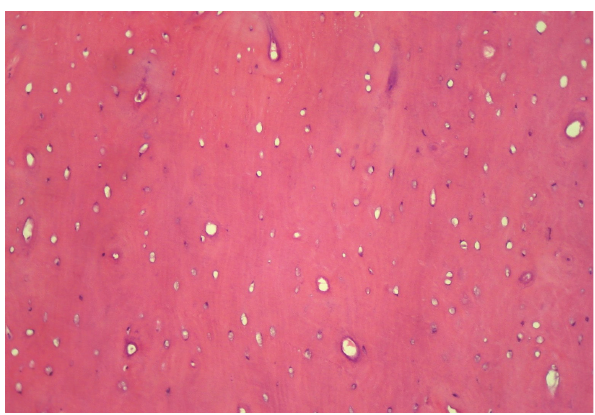
Figure 6: Microscopic features of peripheral osteoma consisting of mature lameller compact bone (haematoxylin-eosin, original magnification ×